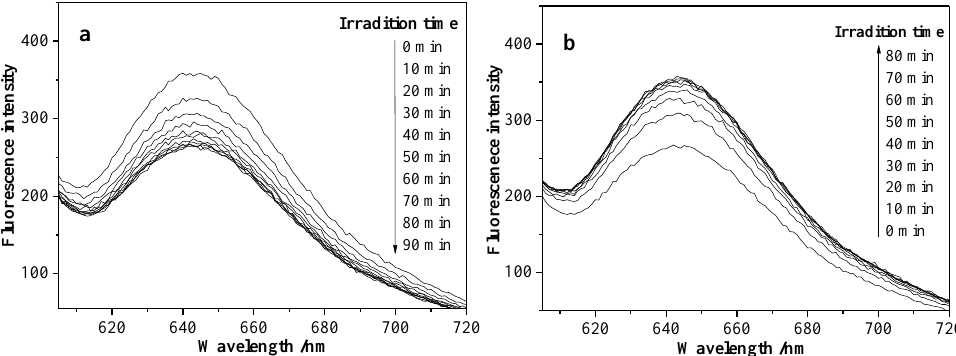
Figure 10. Fluorescence spectra of NR-S3 micellar solution under the irradiation of UV light (365 nm, 200 μ Wcm − 2 ) for 90 min ( a ) and the irradiation ofvisible light for 80 min ( b ). Figure 11a,b show the fluorescence spectra and maximum intensity value at pho- toisomeration equilibrium state under alternating irradiation of UV and visible light four times. As can be seen, the maximum intensity value was basically not changed at pho- toisomeration equilibrium state after repeating several times.